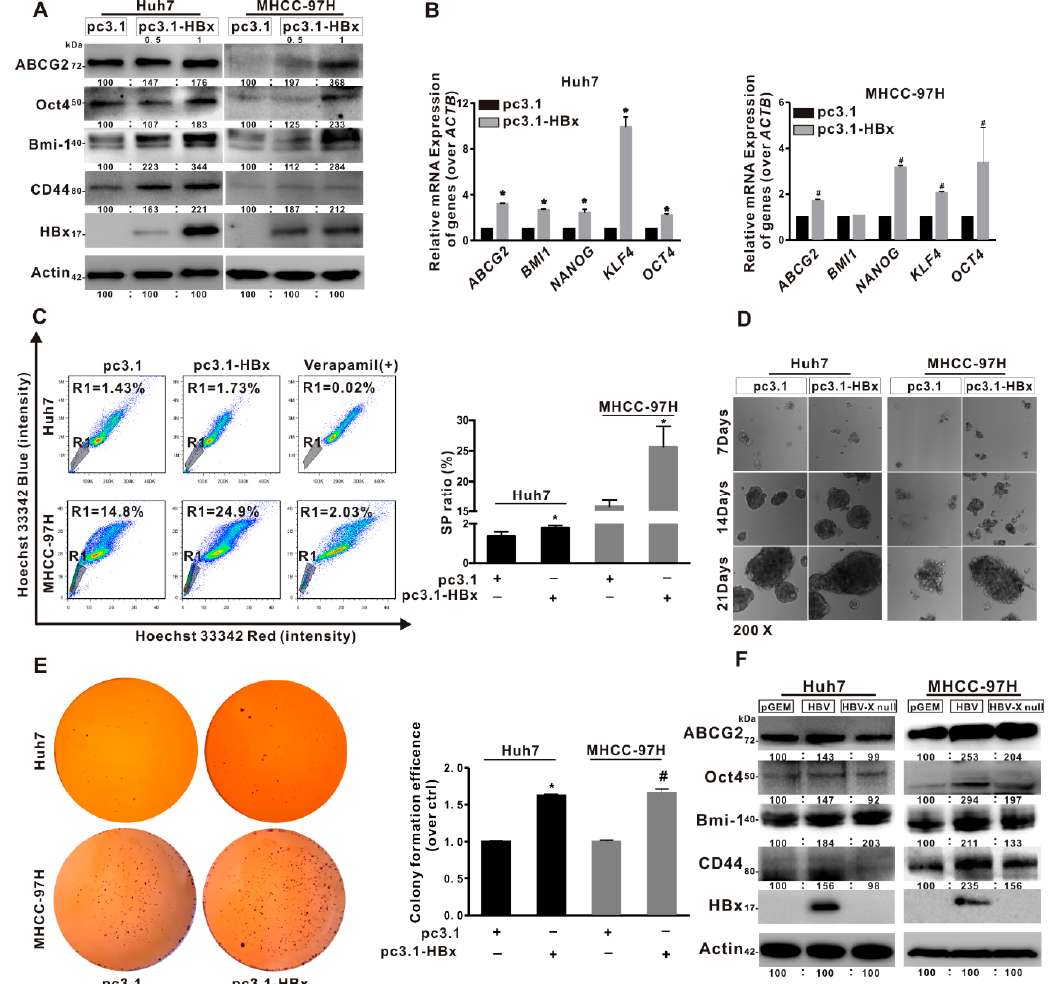
Figure 2. HBx promoted cancer stemness phenotype of the HCC cells. ( A – E ) The two HCC cell lines without or with HBx-expressing were transiently transfected with pcDNA3.1 or pcDNA3.1-HBx (0.5, 1 μ g/mL) for 8 h and then restored culture for another 48 h. ( A , B ) The expression levels of cancer stemness-related proteins ( A ), and the mRNA levels of cancer stemness-related genes ( B ) in two HCC